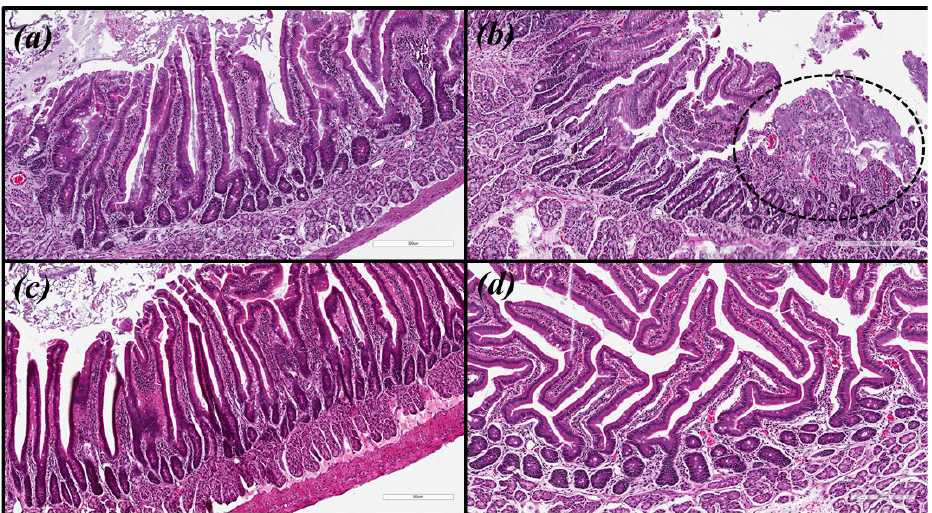
Figure 3. Biological tissue images (antrum-pyloric) of rats stained with hematoxylin and eosin (HE). ( a ) Uninfected group. ( b ) Infected group—the circled area demonstrates the ulceration and the intense mononuclear inflammatory infiltrate in the submucosa. ( c ) Group infected and treated with triple therapy (amoxicillin 50.0 mg/kg, clarithromycin 25.0 mg/kg, and omeprazole 20.0 mg/kg)—note the integrity of the epithelial lining and the lower density of lymphocytic infiltrate in the submucosa. ( d ) Group infected and treated with 300 mg/kg of crude hydroalcoholic extract of Brazilian red propolis—note the integrity of the epithelial lining and the lower density of lymphocytic infiltrate in the submucosa.